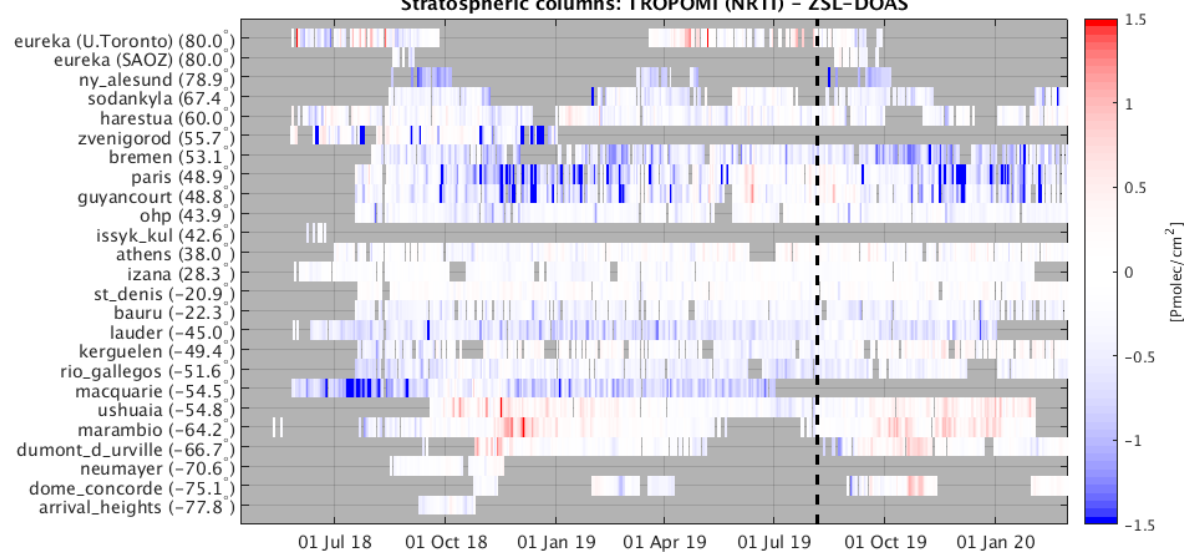
Figure 5. Difference between the S5P TROPOMI and NDACC ZSL-DOAS NO 2 stratospheric column data as a function of time, after photochemical adjustment of the ZSL-DOAS sunset data to the S5P SZA. Stations are ordered by increasing latitude (south at the bottom). The dashed vertical line on 6 August 2019 represents the reduction in S5P ground pixel size from 7 . 0 × 3 . 5 to 5 . 5 × 3 .